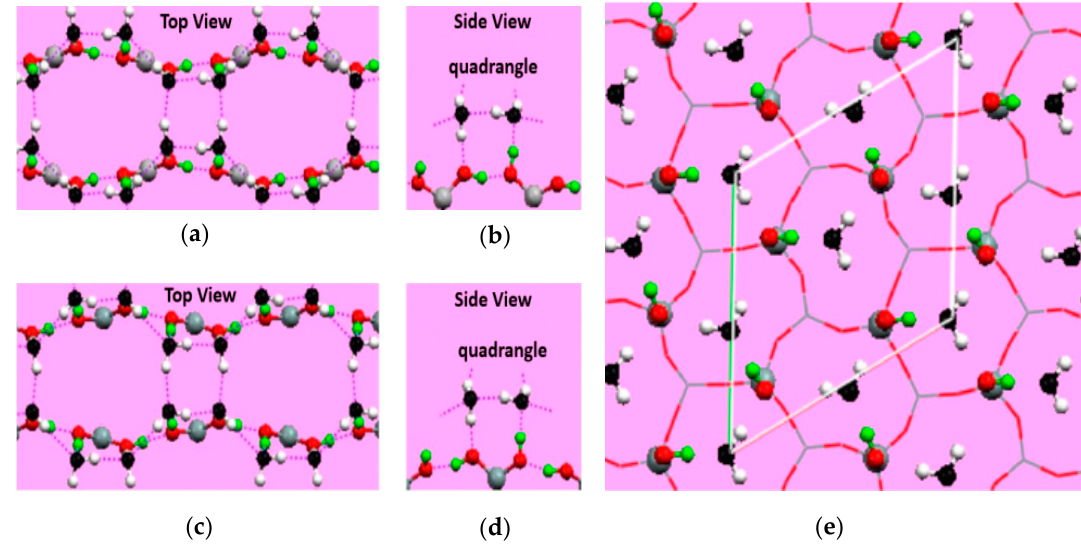
Figure 3. Water adsorption on different crystallographic planes obtained in molecular dynamics (MD) simulations. ( a ) Adsorbed water structure on two different adsorption sites of the β -cristobalite(100) surface, i.e., the bridge site of two adjacent vicinal hydroxyl groups ( a , b ) and that of two adjacent geminal silanols ( c , d ). The water molecules have been colored with black oxygen and white hydrogen to distinguish from the hydroxyl groups on the surface (colored dark gray and light grayd). ( e ) Adsorbed water structure on the β -cristobalite(111) surface. Reprinted from Ref. [36], Copyright 2005, with permission from APS publications.